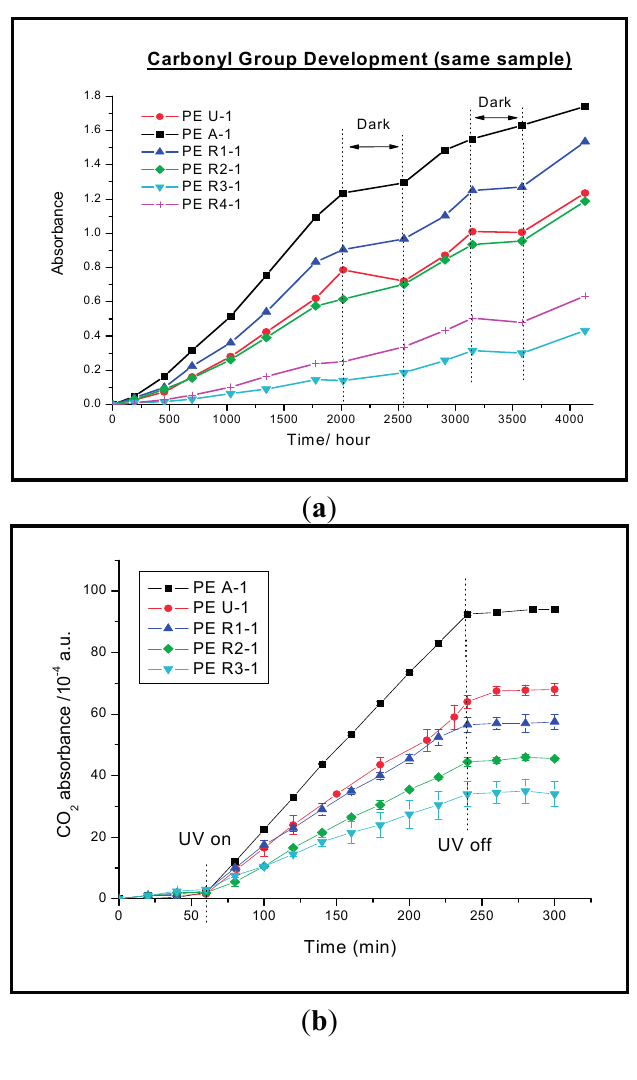
Figure 10. ( a ) The development of carbonyl absorption in unpigmented and pigmented polythene films (PE A-1, ■ ; PE R1-1, ▲ , PE U-1, ● ; PE R2-1, ♦ ; and PE R3-1, ▼ and PE R4-1, ┼ . as a function of exposure in QUV accelerated weathering equipment. After recording each IR spectrum the disc was returned to the exposure unit for further UV exposure); ( b ) CO 2 evolution from the photo-oxidation of the same films as used for the carbonyl development measurements in Figure 10a but exposed to irradiation from a xenon lamp